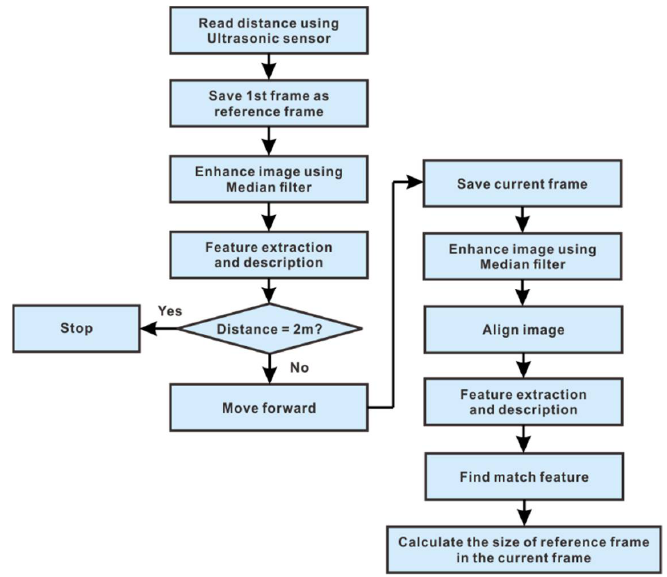
Figure 9. Pre-processing image.